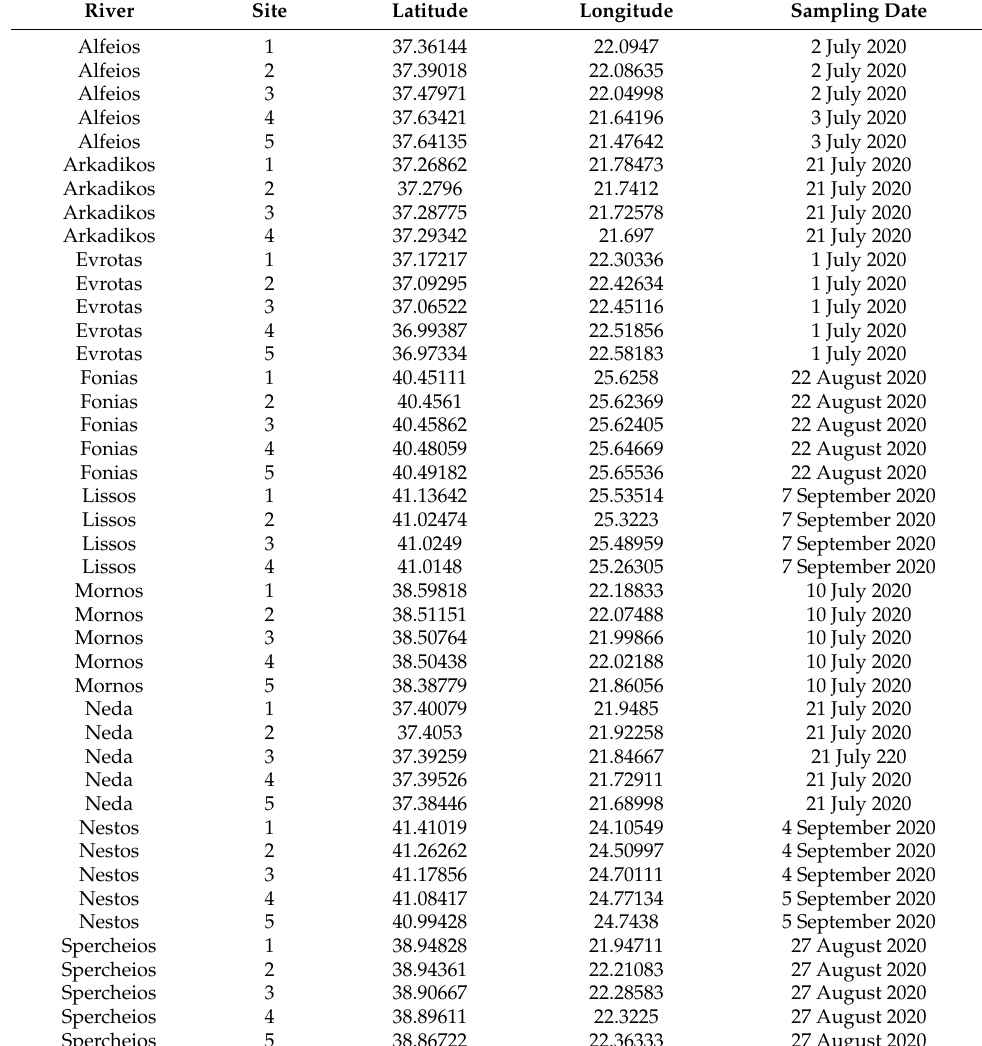
Table A1. Coordinates and sampling dates of each site. Site numbers 1–5 correspond to sites from upstream to downstream.